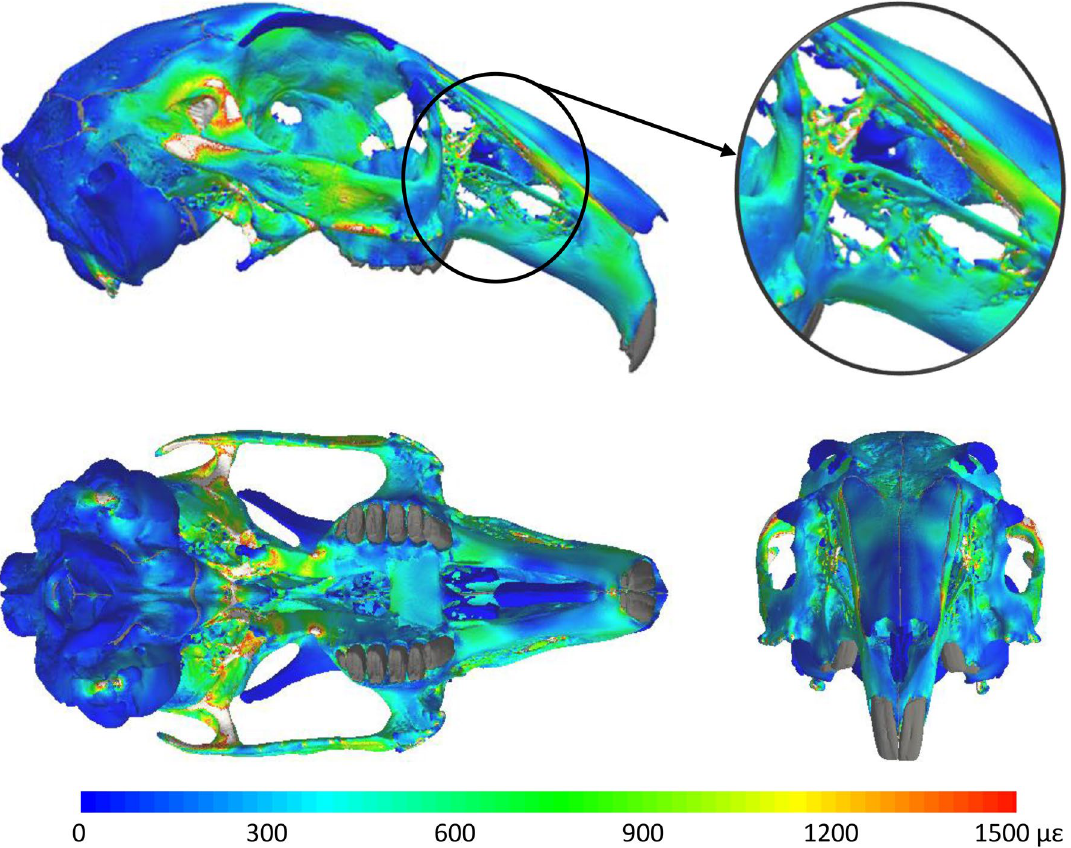
Figure 2. Peak von Mises strain generated throughout the cranium by 12 separate unilateral bites (2 incisor and 10 molar bites). The plots show the largest strain in each element from any of the separate bites. The insert shows the strains in the rostrum. Regions in light grey represent strains above 1500µ ɛ , teeth and sutures are shown in dark